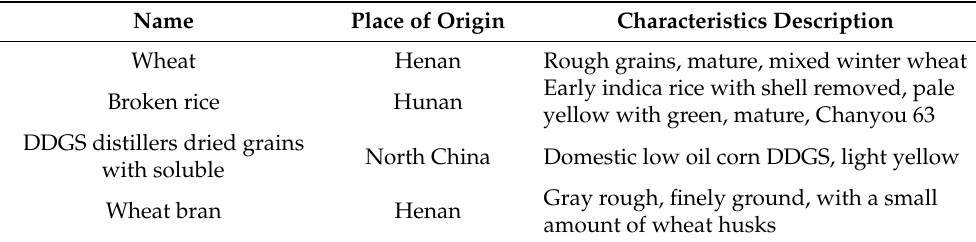
Table 1. The characteristics of the feedstuff